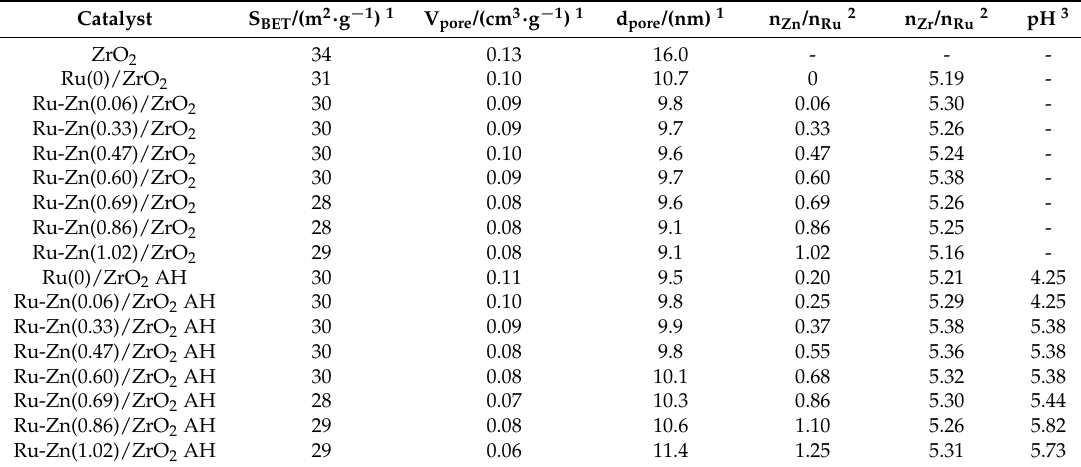
Composition and texture properties of Ru-Zn(x)/m-ZrO 2 catalysts before and after hydrogenation, as well as pH values of the slurry after catalytic experiments.